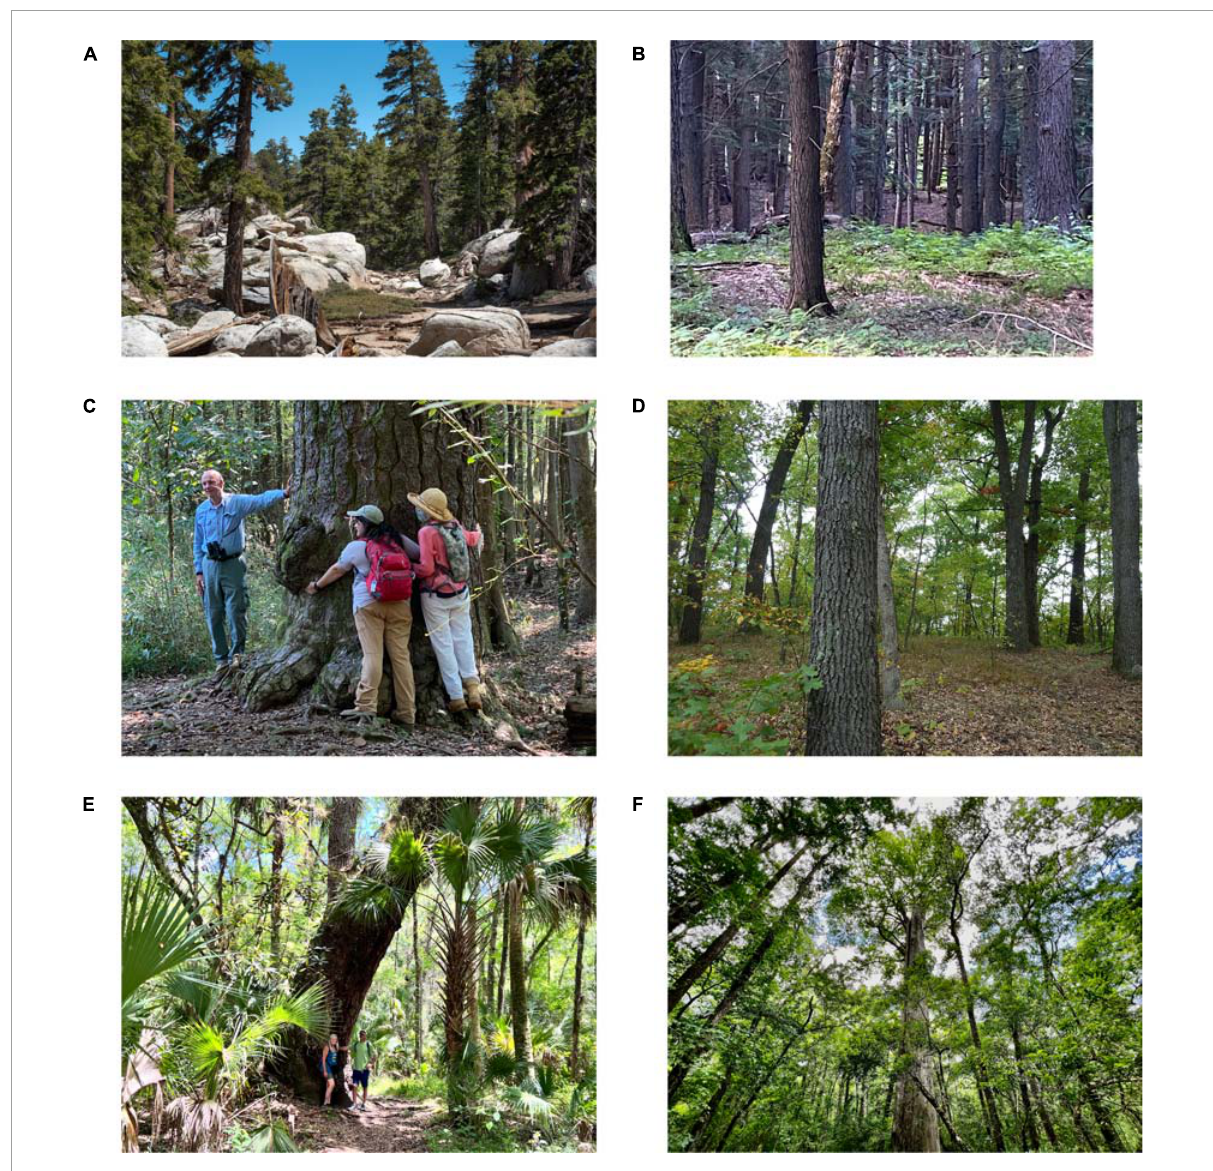
FIGURE4 Examplary photographs of mature and old-growth forests in the United States. (A) Mixed-conifer forest, Sequoia National Park, CA, United States (B. Bryant). (B) Mature Eastern Hemlock ( Tsuga canadensis ) stand, Huron Mountain Club Upper Peninsula, MI, United States (B. Boucher). (C) Bottomland hardwood forest, Congaree National Park, SC, United States (J. Maloff, Old Growth Network). (D) North-Central Interior Dry-Mesic Oak Forest and Woodland (B.S. Slaughter). (E) Hardwood hammock forest, Starkey Park, FL, United States (D. DellaSala). (F) Top ten largest bald cypress ( Taxodium distichum ) in Florida, Upper Pithlachascotee River Preserve (D. DellaSala). Nearly all old growth cypress was logged in the 1930s.